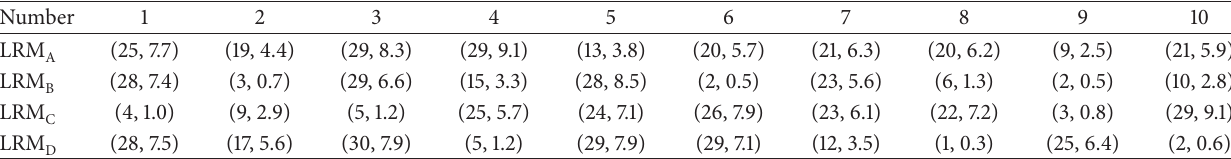
Table 1: The RULs of the LRM.